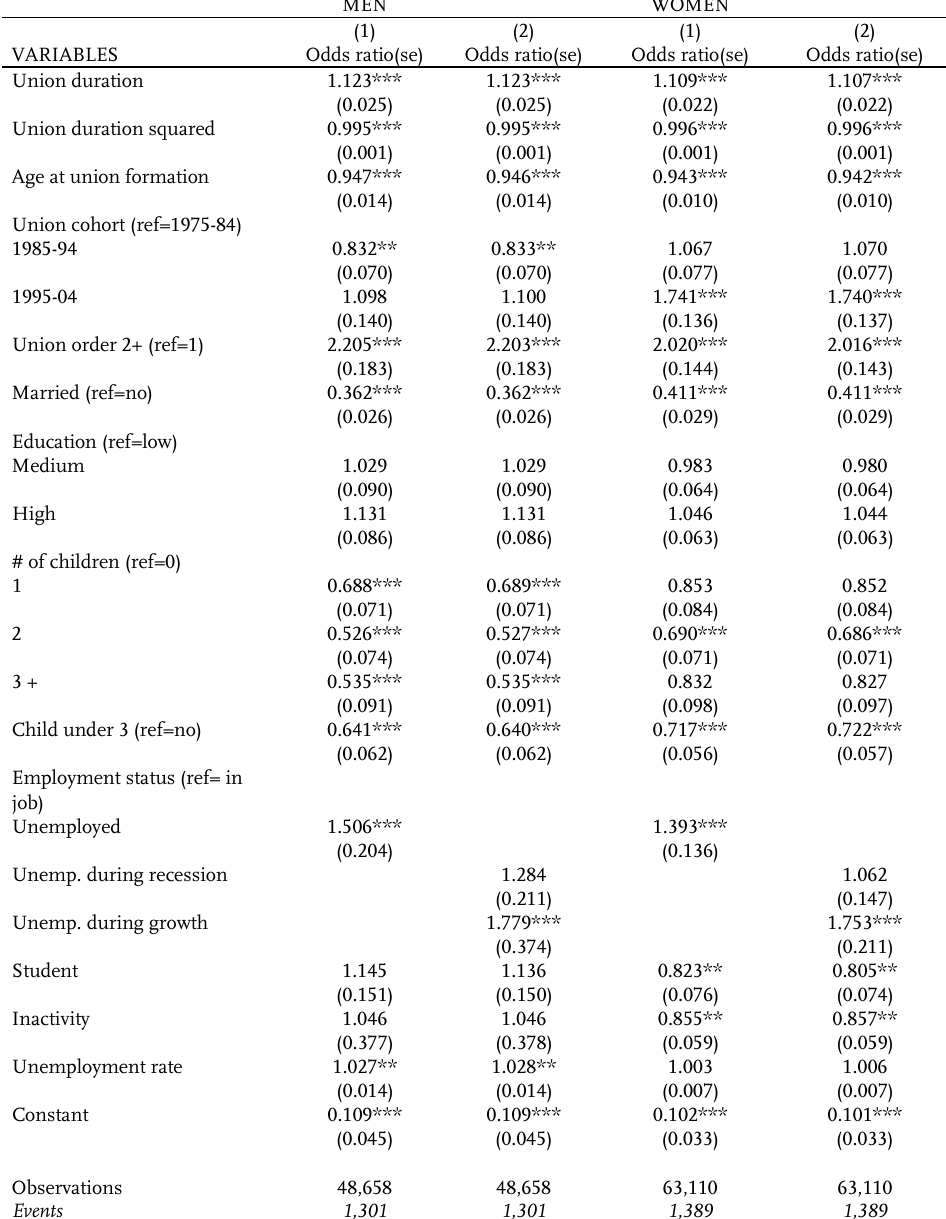
Table A.3 : Discrete time model, full results by country: